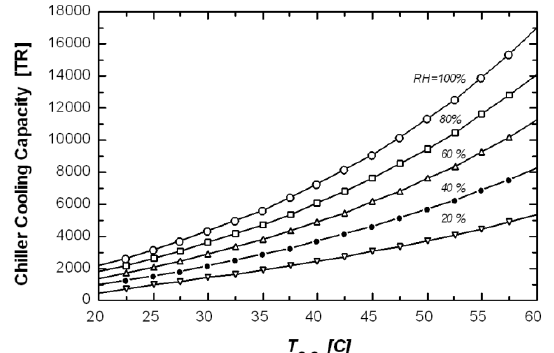
Fig. 5. Dependence of chiller cooling capacity on the climatic conditions